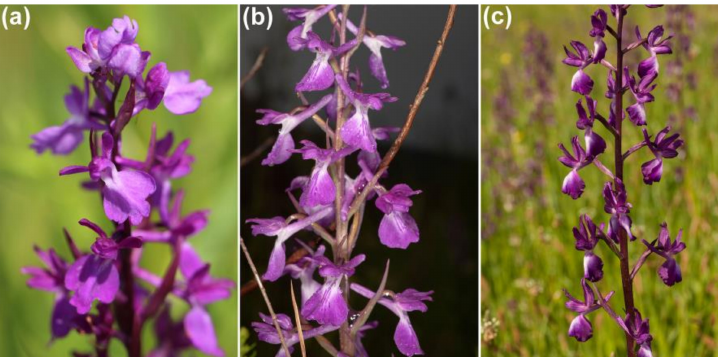
Figure 2. Some representatives of the genus Anacamptis of wetland vegetation in the Central Balkans: ( a ) Anacamptis palustris subsp. palustris , ( b ) Anacamptis palustris subsp. elegans , ( c ) Anacamptis laxiflora (( a ) photo I. Stevanoski; ( b , c ) photo S.